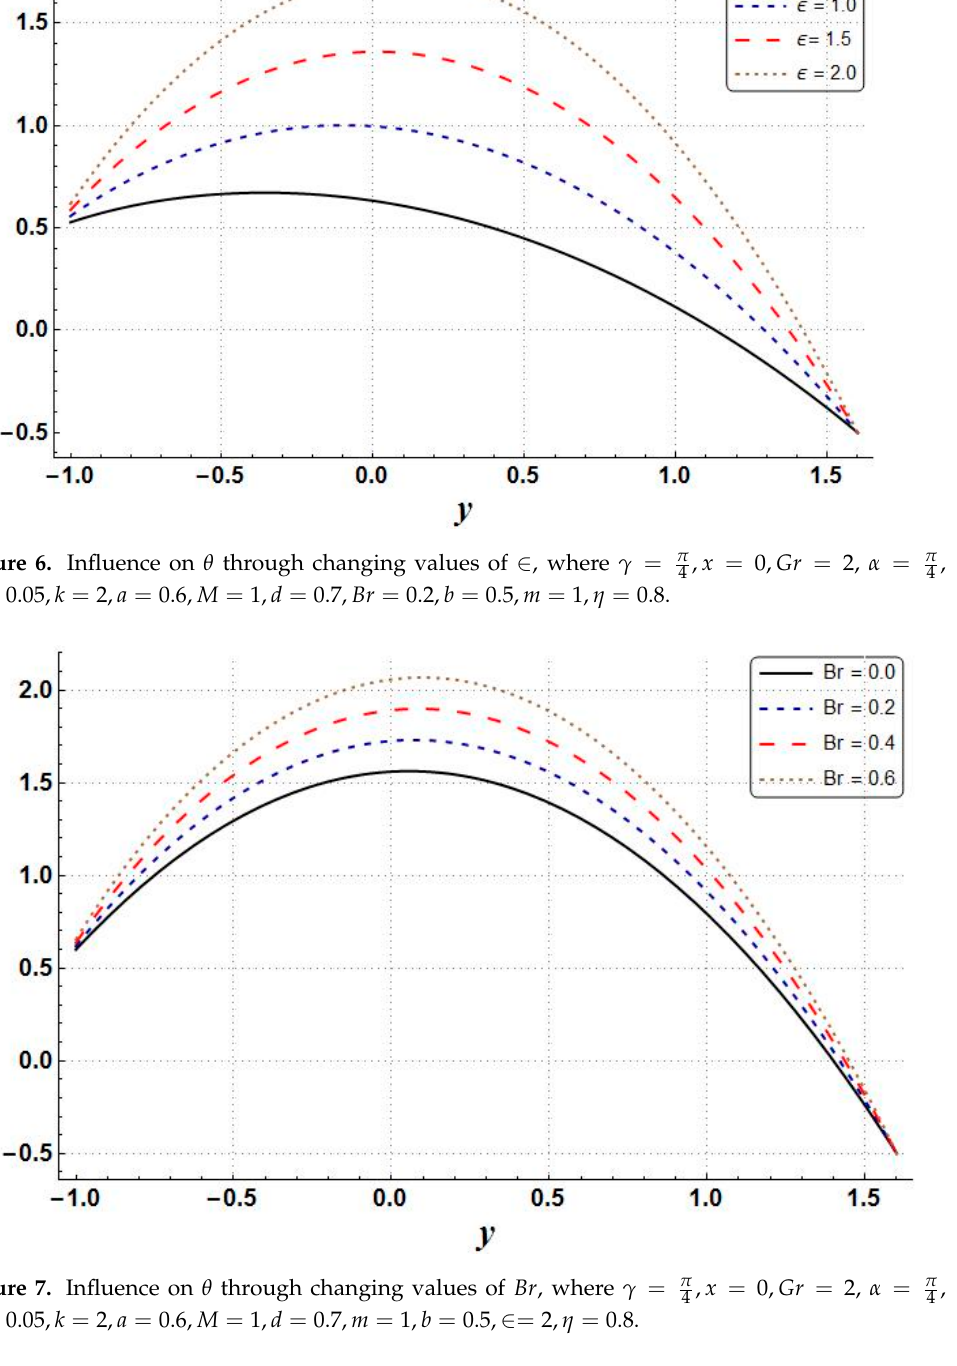
θ through changing values of